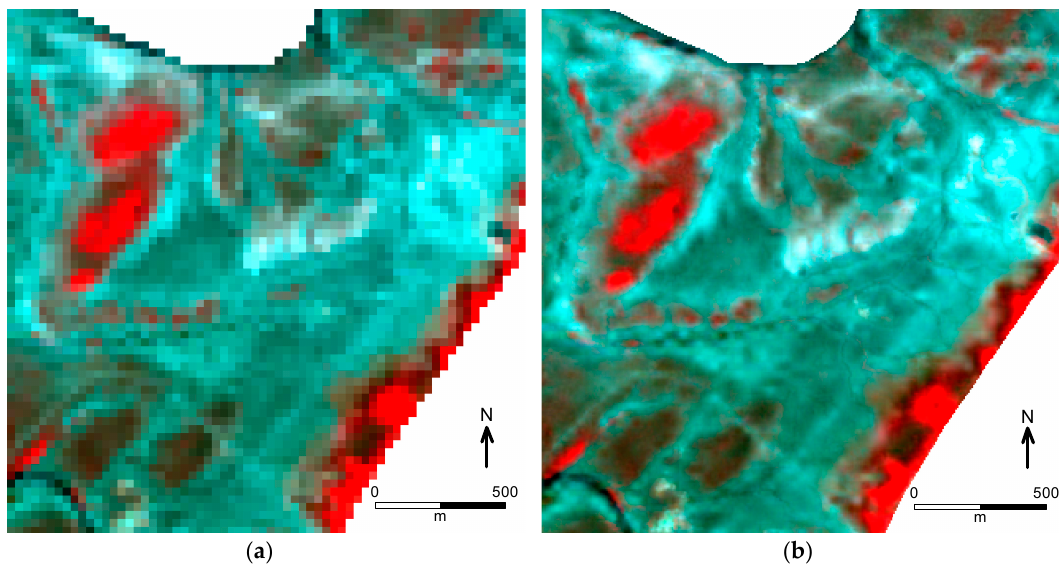
Figure 8. ( a ) Original Landsat image (1 July 2014, 5-4-3) and ( b ) images downscaled by cokriging (126.60°E, 35.73ºN).